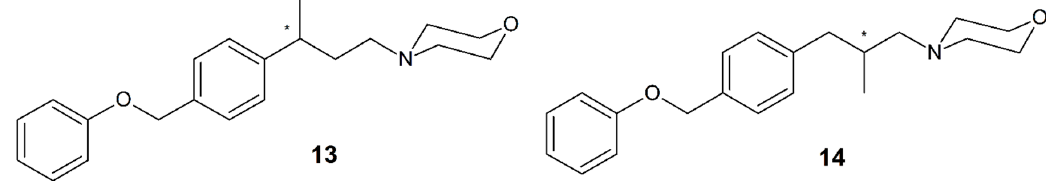
Scheme 12. Chiral derivatives ( + )-O / G5 ( 13 ) and ( − )-O / G3 ( 14 ) of compound ( 12